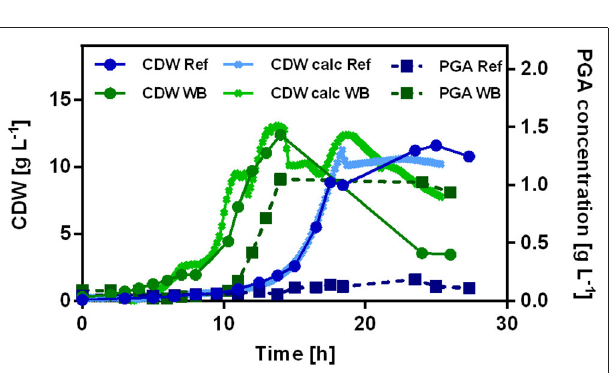
FIGURE 7 | Batch fermentation of B. subtilis Ref PX43- pgs (blue) and B. subtilis WB PX43- pgs (green) on xylose. The cell dry weight was monitored offline and online using the BioR-CGQ (circles). The γ -PGA concentrations are depicted (squares).